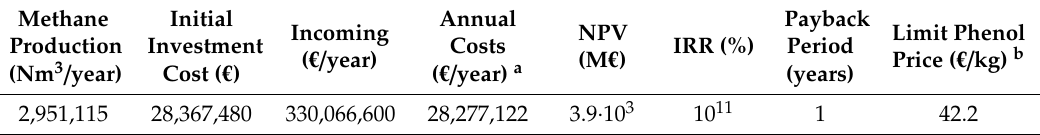
Table 5. Economical